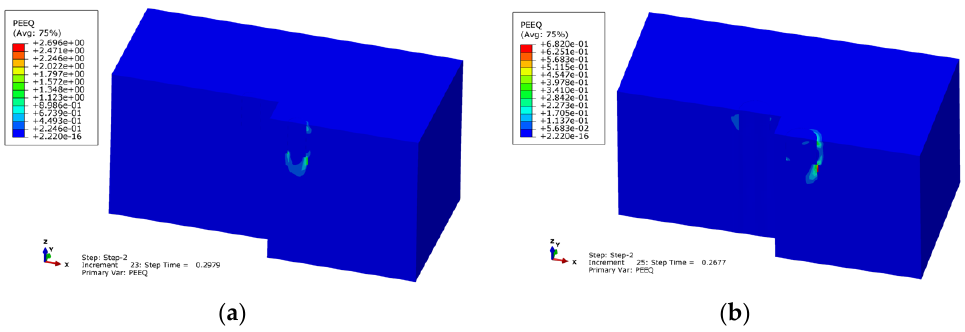
Figure 12. Soil equivalent plastic strain contours at 1# and 2# bucket central section for the TSPJF and TBJF under the ultimate horizontal load. ( a ) TSPJF, ( b ) TBJF.